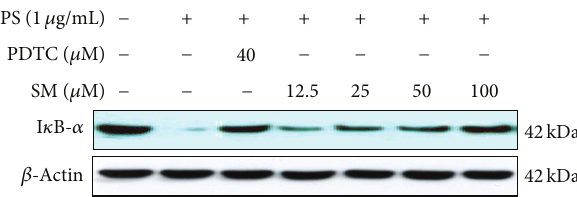
Figure 4: The effects of sargachromenol on the degradation of I 𝜅 B 𝛼 in LPS-stimulated RAW 264.7 cells. RAW 264.7 cells (1.0 × 10 6 cells/mL) were stimulated with LPS (1 𝜇 g/mL) in the presence of the indicated concentrations of SM or PDTC (40 𝜇 M) for